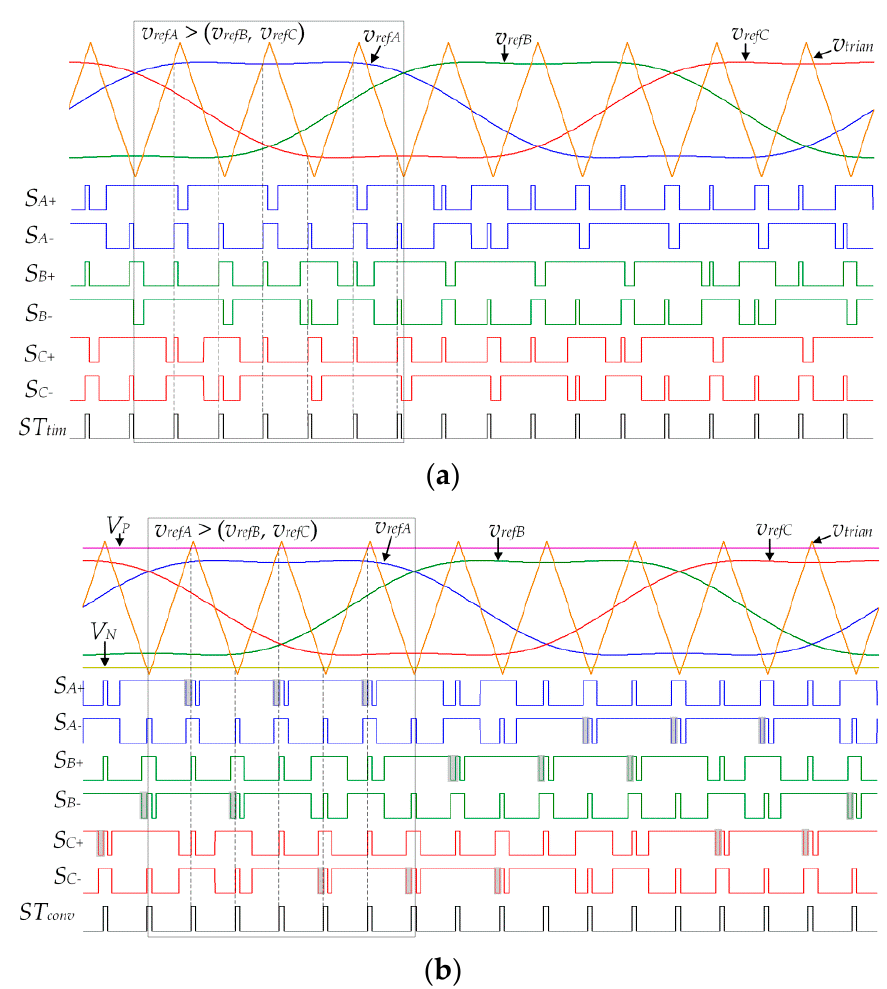
Figure 2. Waveforms of the zero-sync STS injection method ( a ) and the conventional STS injection method ( b ), with 0 < D 0 < D 0, max.